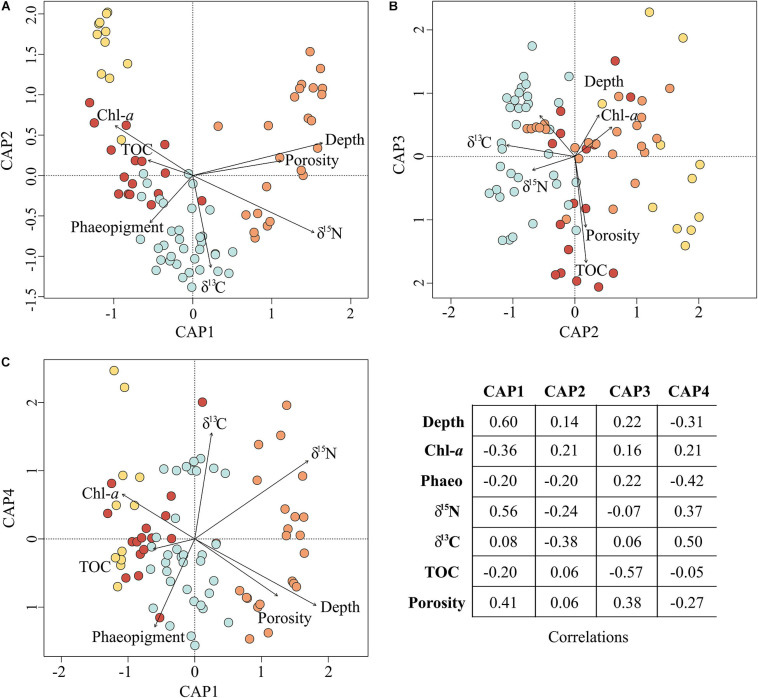
Environmental parameters influencing prokaryotic assemblage structure. The ordination plots above depict the results of Constrained Analysis of Principal Coordinates. All included environmental parameters are significant correlates (P < 0.001) to the first four CAP axes (A–C) and, in total, explained 18% of the variation in prokaryotic community structure (R2 = 0.18). The corresponding correlations are reported in the table for all axes.